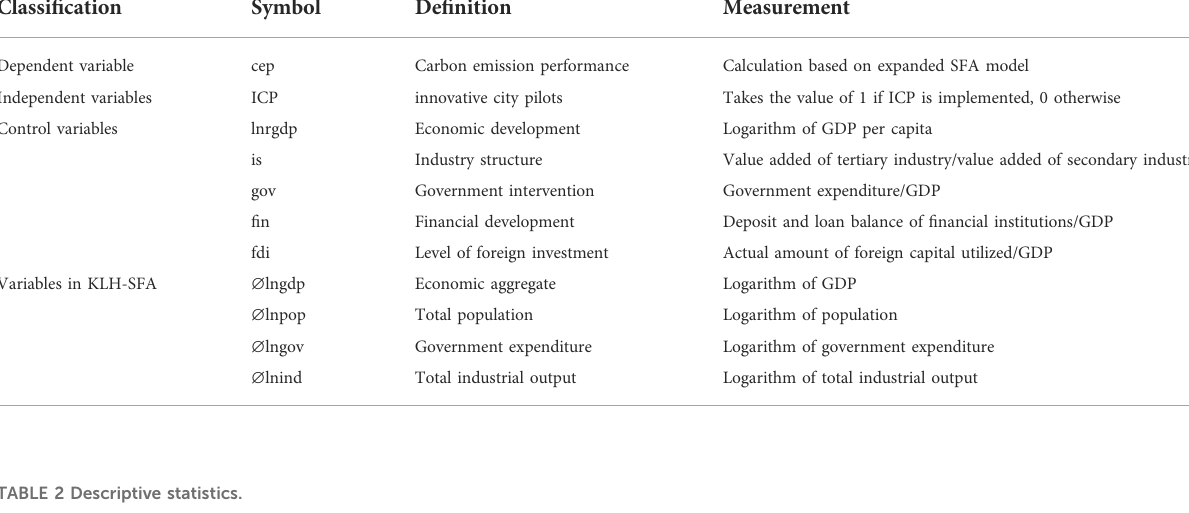
TABLE 1 Variable de fi nition.